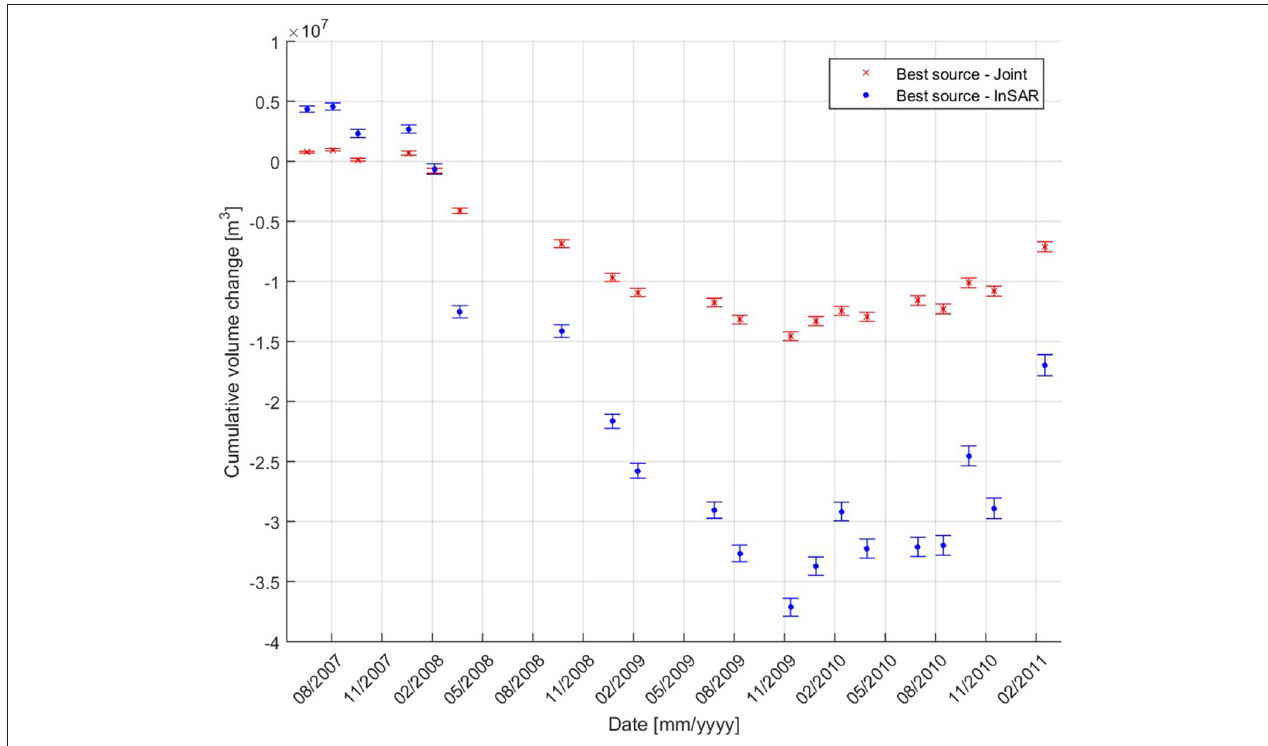
FIGURE 8 | Time series inversion constrained by InSAR data for two source locations: the best location determined via joint inversion (red) and the best location determined by InSAR-only inversion (blue). 1-sigma uncertainties are plotted as error